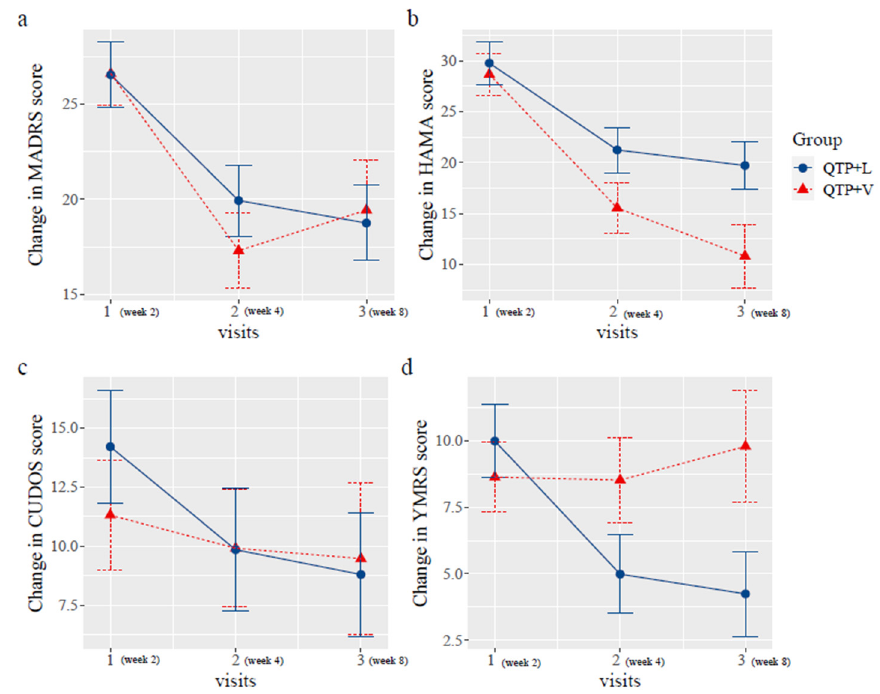
Figure 2. Change of MADRS, HAMA, CUDOS-M and YMRS scores of QTP + L and QTP + V group during six weeks treatment. QTP + V: quetiapine plus valproate group; QTP + L: quetiapine plus lithium group; analyses were conducted with the use of a generalized linear mixed model, treating group as fixed effect, patient ID as random effect, time *group as interaction and age, sex as explanatory variables.